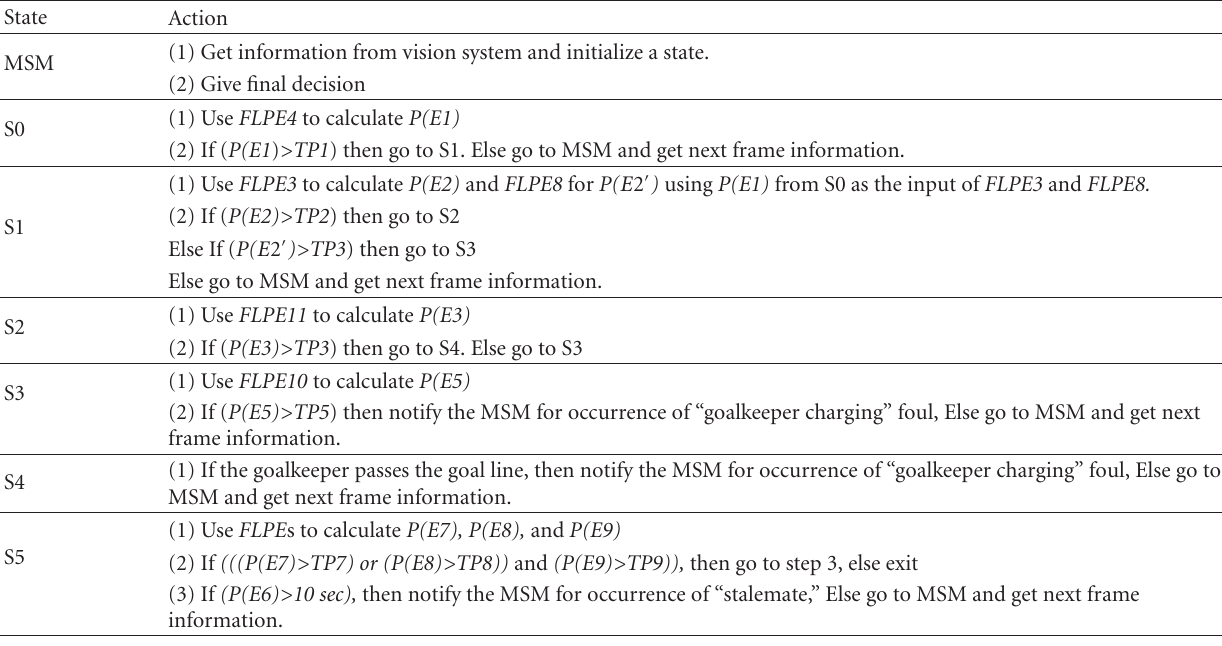
Table 1: The states and actions taken for Figure